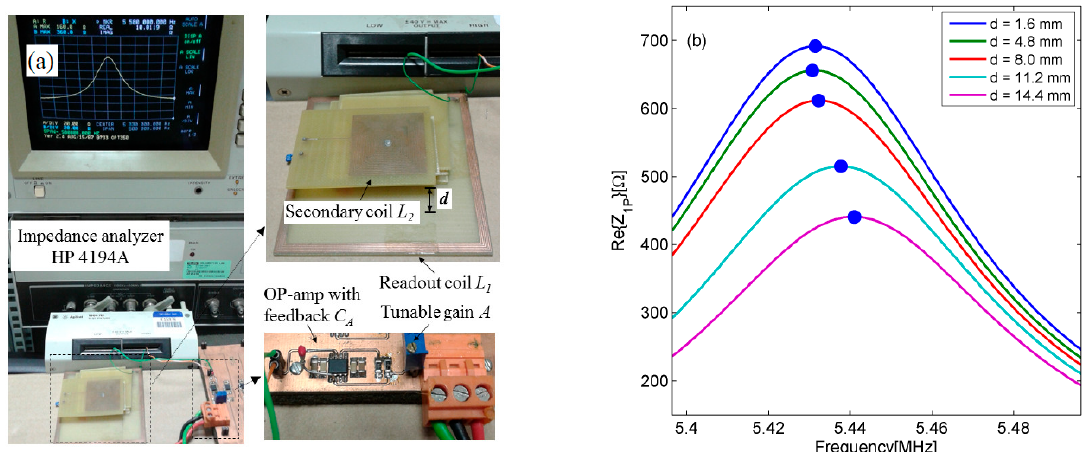
Figure 3. ( a ) Pictures of the experimental setup. ( b ) Re{ Z 1 P } measured near f S for different values of the interrogation distance d considering a parasitic capacitance C P = 47 pF and without the compensation circuit applied.